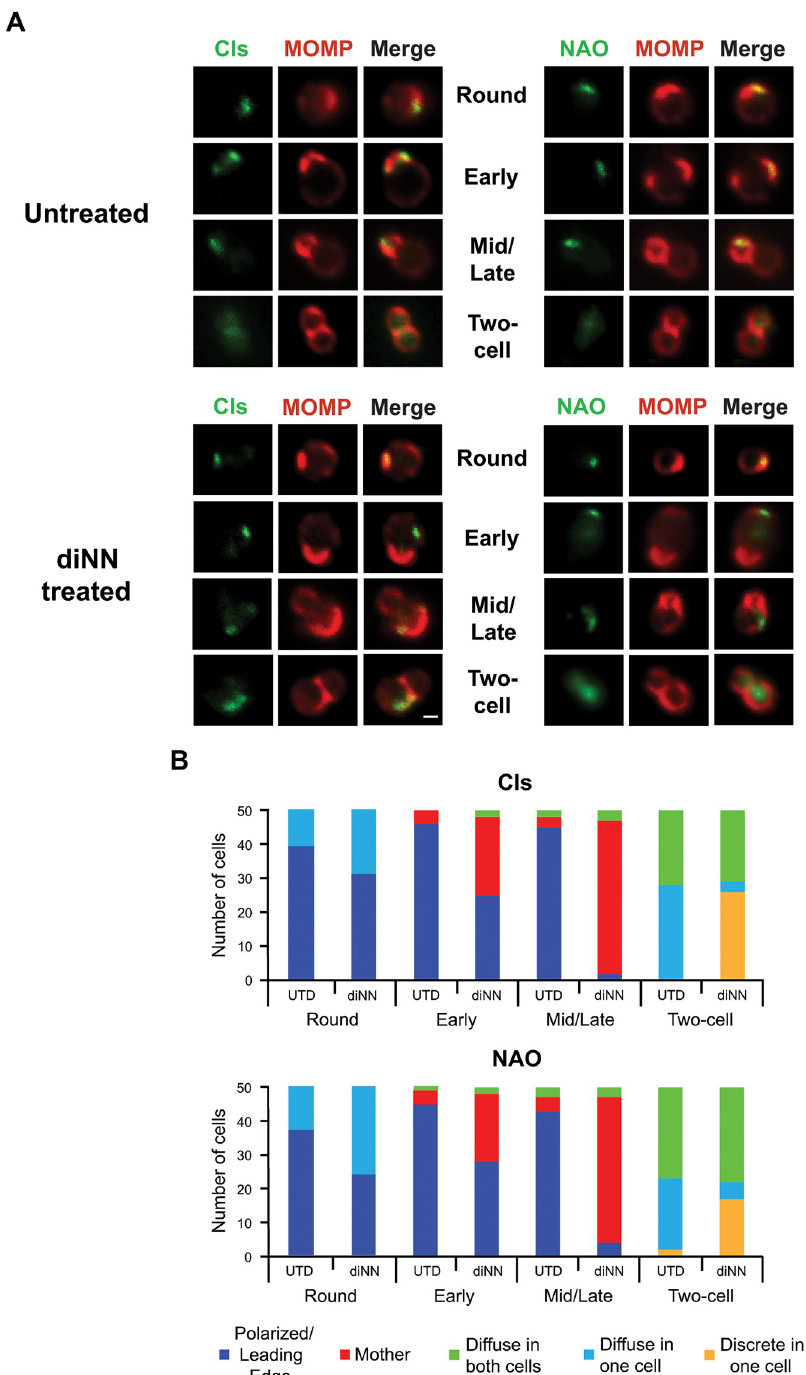
Fig 4. Effect of the CL-targeting antibiotic 3’,6-dinonylneamine (diNN) on the localization of Cls_6xH and aPLs at different stages of the division process. HeLa cells were infected with the Cls_6xH transformant, and at 22hpi, infected cells were lysed and Cls_6xH expression was induced by incubating the cells in the lysate for 1.5hrs. in axenic media containing 10nM aTc in the presence or absence of 5 μ M diNN. Cells were then fixed and the distribution of MOMP, Cls_6xH (labeled Cls), or NAO in chlamydial cells was assessed. (A) Representative images of the indicated markers in Untreated or diNN treated bacteria at the indicated stages of cell division. Images were acquired with a Zeiss AxioImager2 microscope equipped with a 100x oil immersion PlanApochromat lens and are representative of two independent experiments. Scalebar = 2 μ m (B) 50 individual cells from the indicated stages of division from